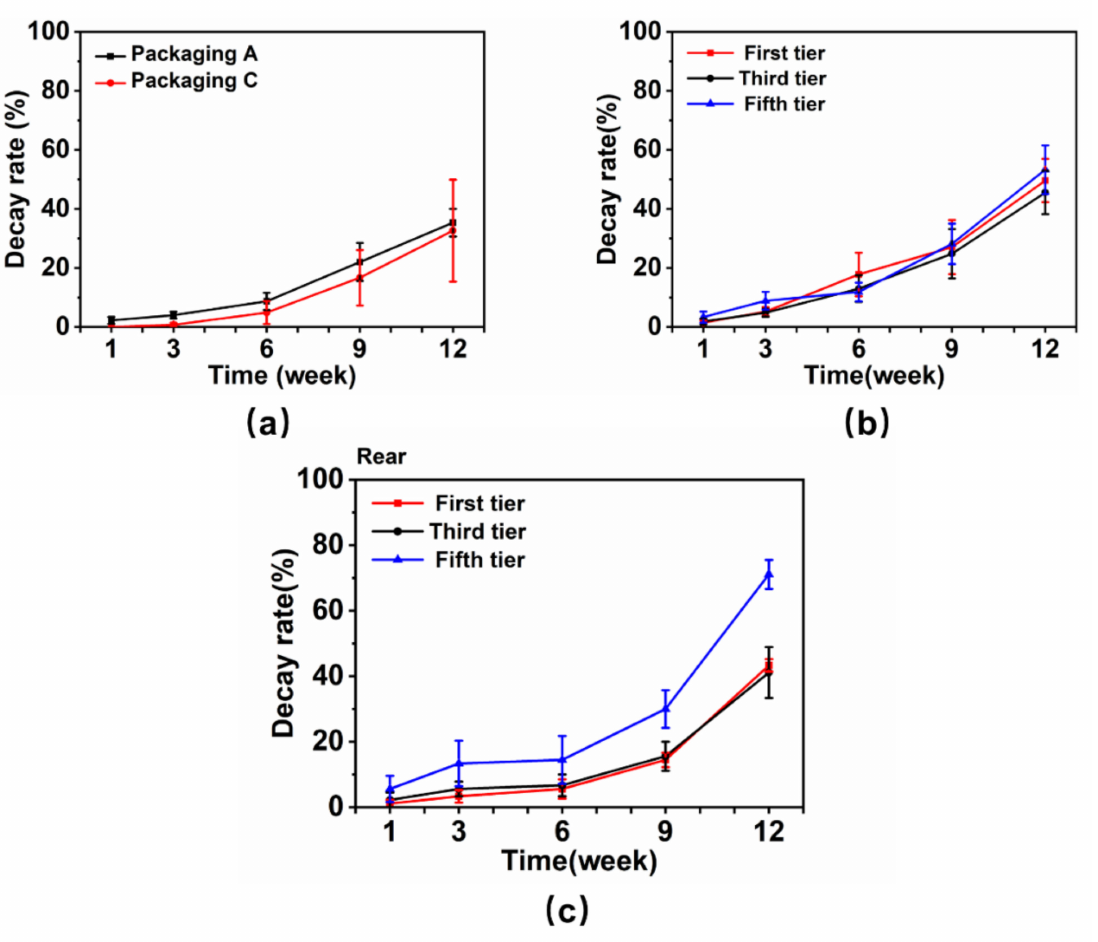
Figure 8. Decay rates during storage after road transportation: ( a ) Decay rates of Packaging A and C during storage after 13 h of Road Test A. ( b ) Average decay rates on Tiers 1, 3, and 5 for Packaging C after 30 h of Road Test B. ( c ) Decay rates of Packaging C at the rear position on Tiers 1, 3, and 5 after 30 h of Road Test B. Vertical bars represent standard